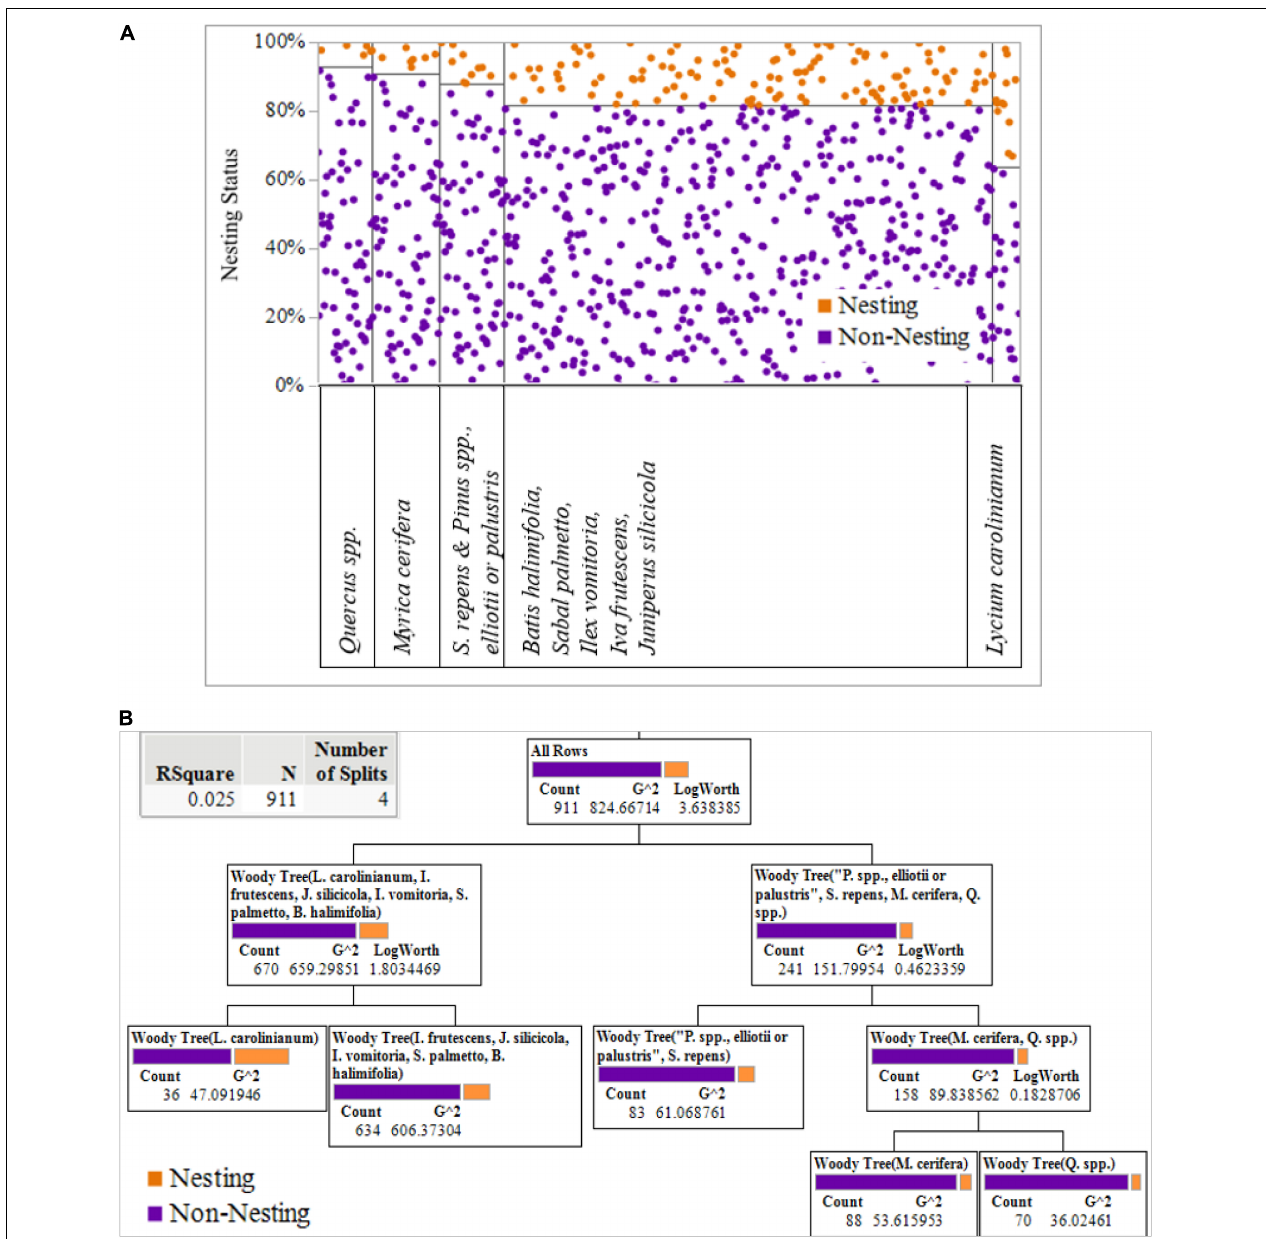
FIGURE 7 | (A) Partition via Classification and Regression Trees (CART) analysis supporting the conclusion that woody plant data suggest that significantly more nesting occurred when Christmas Berry ( Lycium carolinianum ) was present, and nesting was less likely when either Wax Myrtle ( Myrica cerifera ) or Oak ( Quercus spp.) were present. (B) Decision tree with R 2 = 0.025 in the least squares regression with four splits using the CART